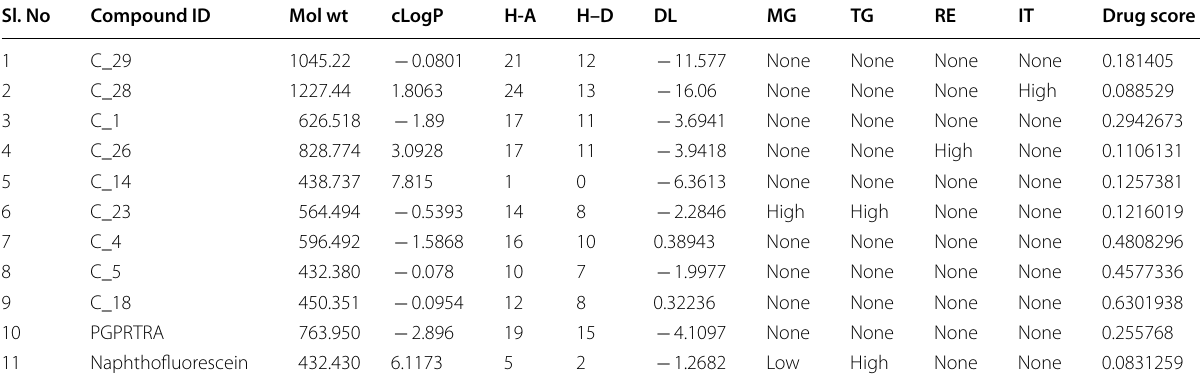
Mol wt. Molecular weight; cLogP = MG Mutagenicity; TG =